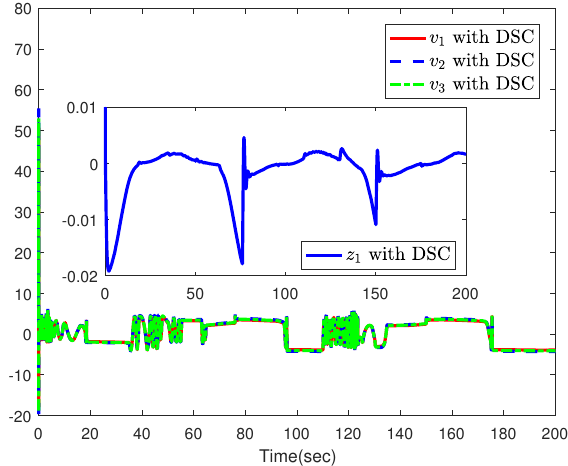
Figure 9. Control effect of System (3) with DSC.